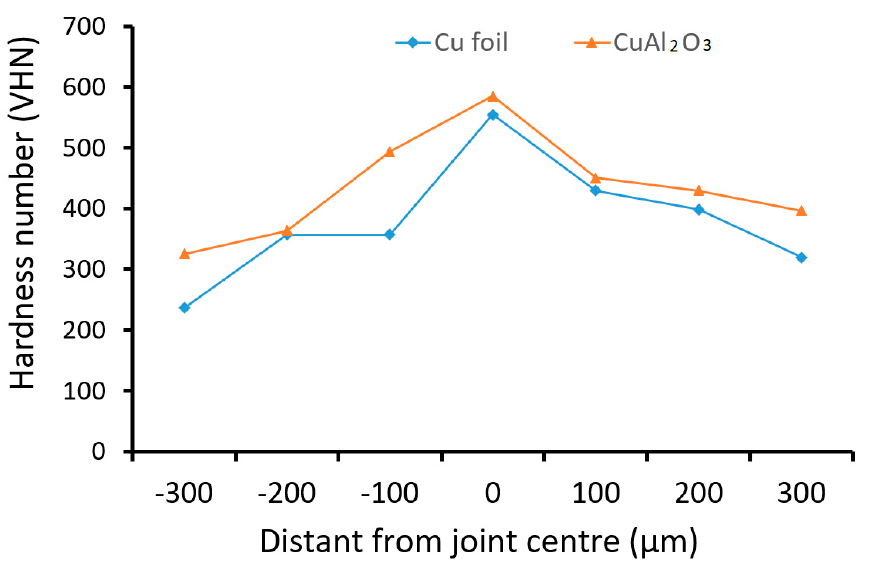
Figure 12. ( A ) Hardness measurements for the sample bonded for 30 min as a function of bonding temperature; ( B ) Hardness measurements for the sample bonded at 850 °C as a function of bonding time.